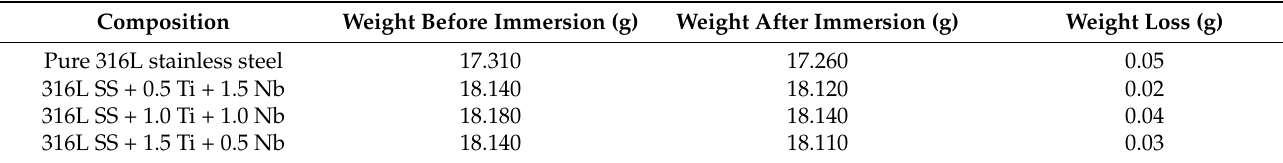
Table 6. Weight loss measurements in artificial saliva